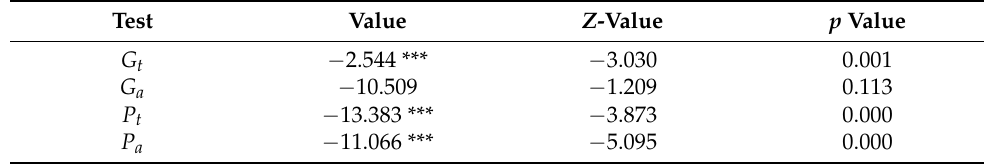
Table 7. Westerlund cointegration test